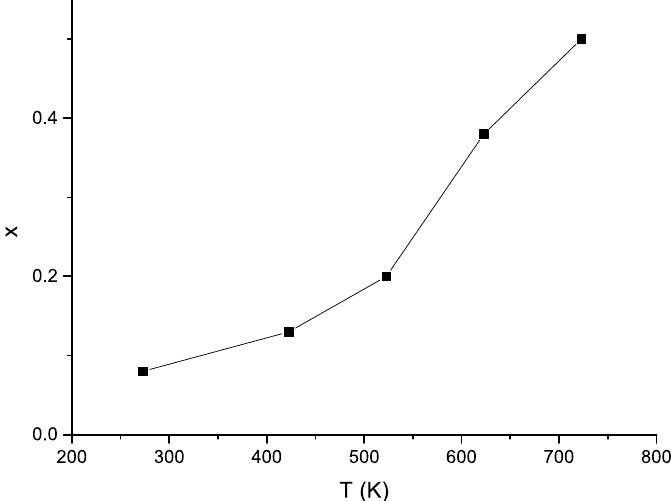
Figure 3. Ratio of oxygen to silicon ( x in SiO x ) in the surface of the samples, as measured using EDS vs. oxidation temperature.